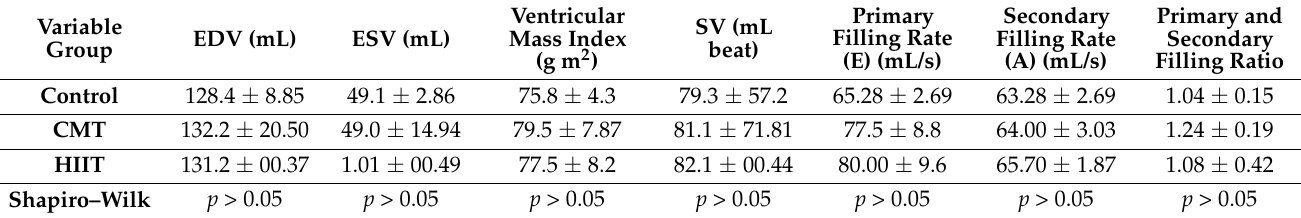
Table 1. Mean and Standard Deviation of Ventricular Volumes and Primary and Secondary Filling